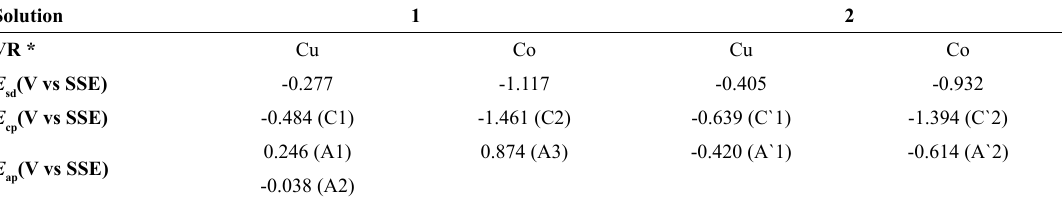
Table 2. Voltammetric results obtained from the experiments on graphite electrode in Solutions 1 (0.02 mol L -1 Cu (II), 0.10 mol L -1 Co (II)) and 2 (0.02 mol L -1 Cu (II), 0.10 mol L -1 Co (II), 0.5 mol L -1 tartrate). Solution